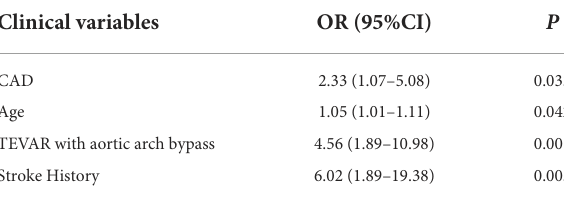
TABLE 3 Multivariable logistic regression analyses for in-hospital